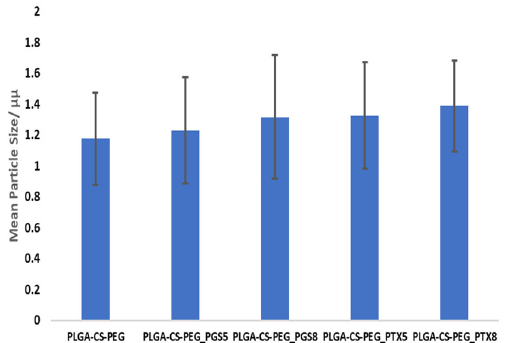
Figure 2. Mean particle size of PLGA-PEG microspheres using Image J Software.